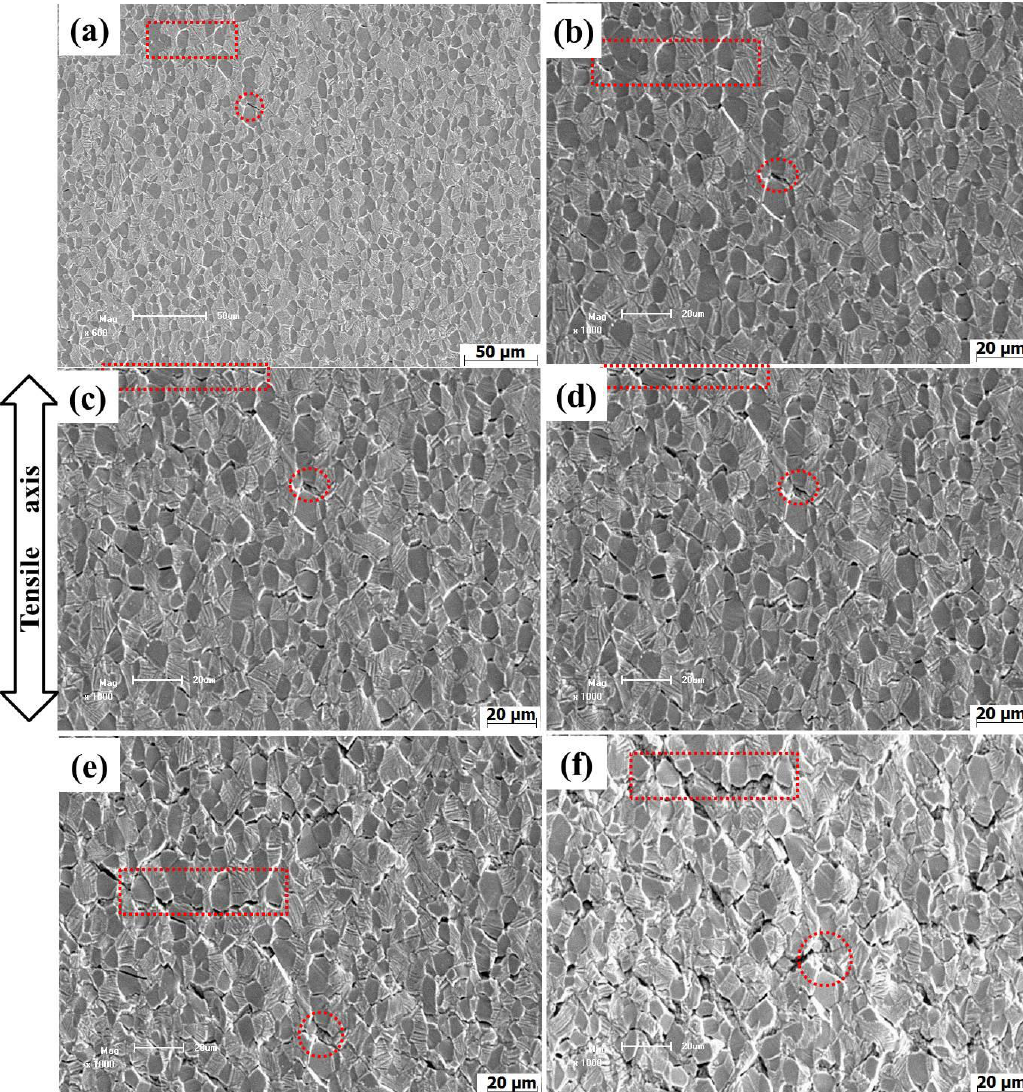
Figure 4. SEM images of the LBA alloy during in-situ tensile process at 650 °C: ( a ) 0.7 mm, ( b ) 1.0 mm, ( c ) 1.4 mm, ( d ) 1.6 mm, ( e ) 1.75 mm, ( f ) 2.0 mm.